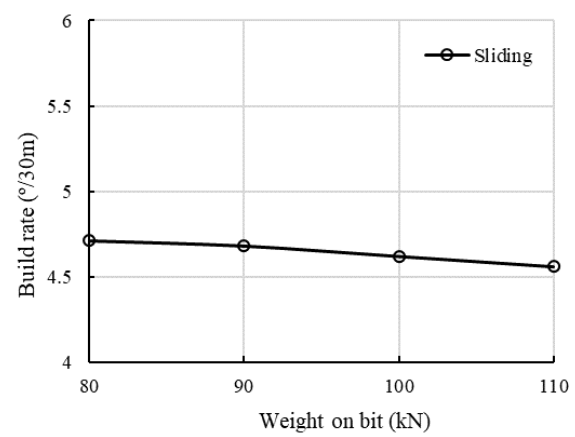
Fig. 14. Sliding build rate VS inclination for BH-PDM-D Fig. 16. Sliding build rate VS WOB for BH-PDM-D BHA BHA